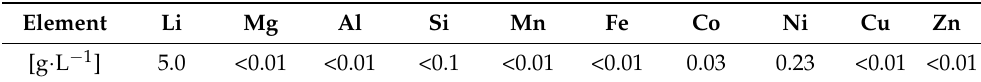
Table 2. Composition of the purified leaching solution after precipitation of Co, Ni, Mn and Al with oxalic acid and sodium hydroxide (measured by ICP-MS).